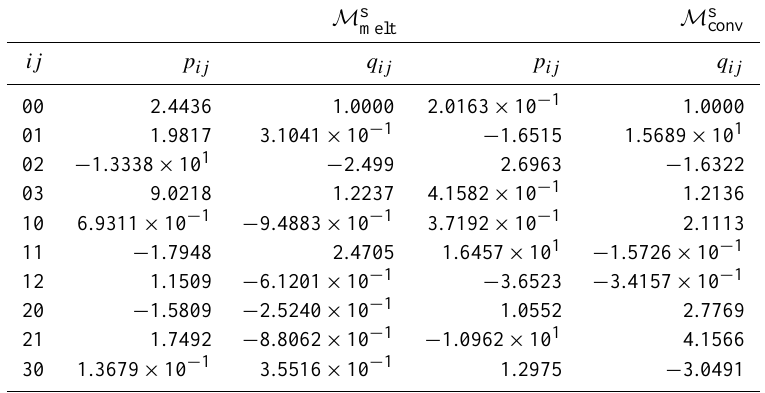
Table 1. The coefficients used within the Pade-type rational function (Eq. 34) for the melting integral and the conversion coefficient.